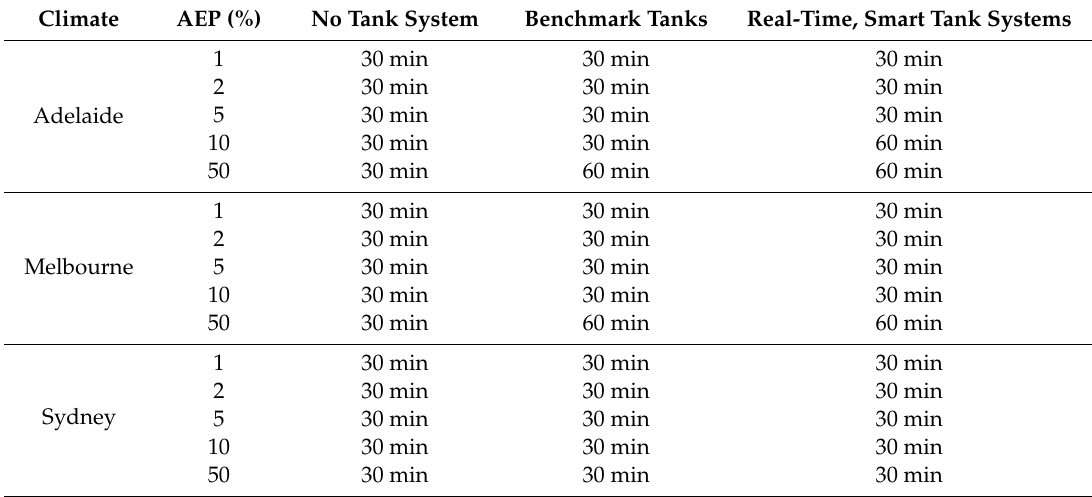
Table A1. Critical duration of no tank system, benchmark tanks and real-time, smart tank systems for a range of AEPs with 2 × 2 m 3 tanks in Adelaide, Melbourne and Sydney.